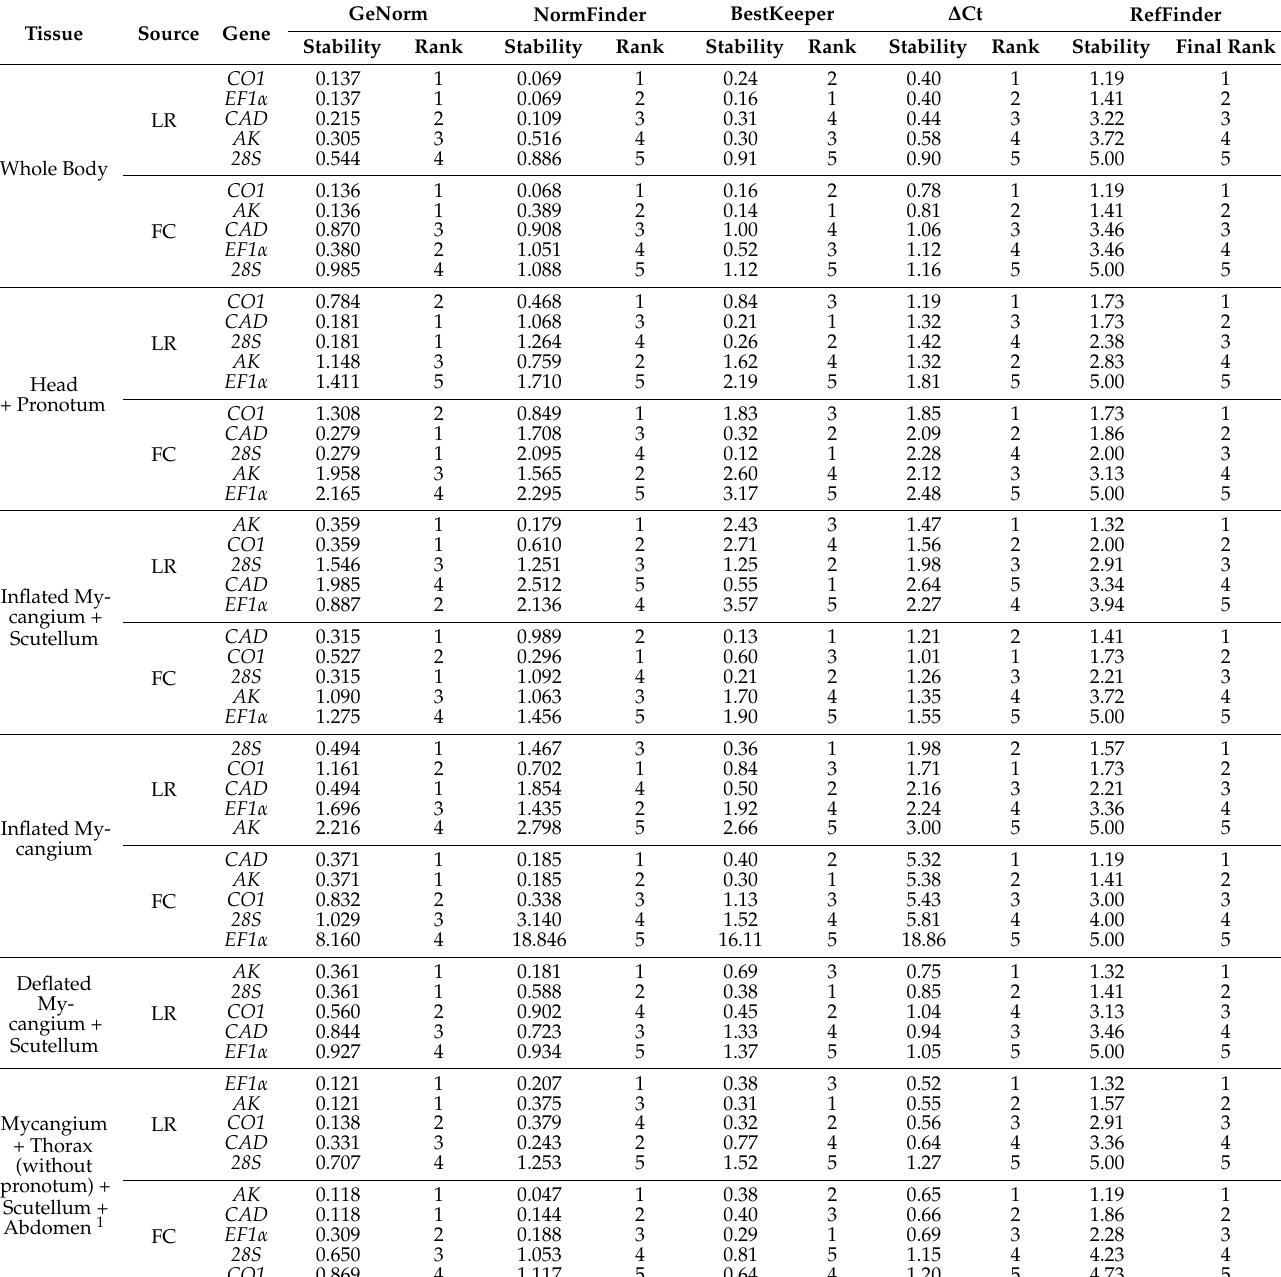
Table 2. Stability and rank values of reference genes in tissue samples of laboratory-reared (LR) and field-collected (FC) X. germanus as determined using the algorithms GeNorm, NormFinder, BestKeeper, ∆ Ct and a comprehensive final ranking by RefFinder. Rank represents a scale of 1–5 with 1 being